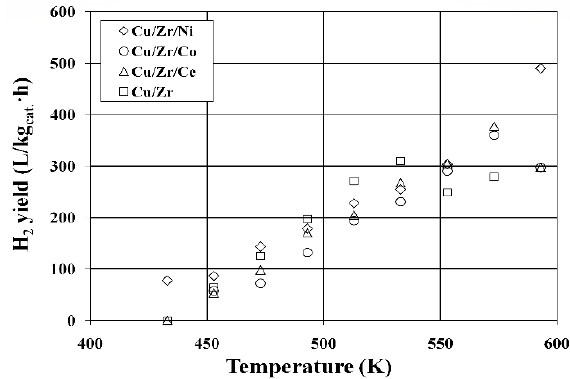
Figure 5. The effect of temperature on ethanol conversion in ethanol steam reforming (ESR) over tested catalysts.